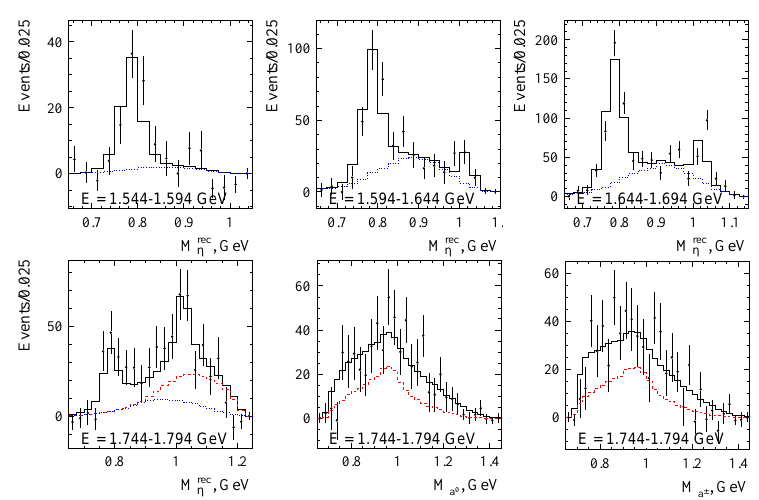
Figure 3. The M rec distribution for data e + e − → π + π − π 0 η events from di ff erent c.m. energy intervals (points η with error bars). The solid histogram represents the result of the fit described in the text. The dotted histogram represents the structureless e + e − → π + π − π 0 η contribution. The dashed histogram represents the e + e − → a 0 ρ contribution.